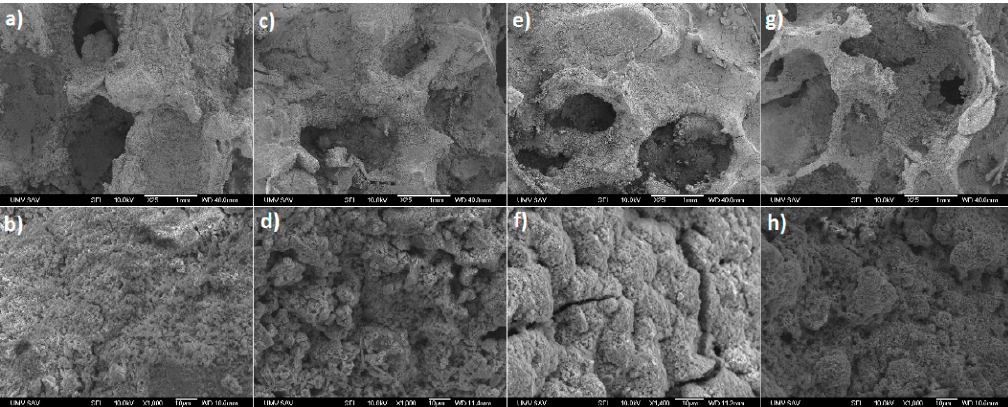
Figure 8. SEM micrographs of sintered iron samples after 12 weeks of corrosion in Hanks’ solution: Fe sample without PEG ( a , b ); Fe-PEG1, 0.8 wt. % PEG ( c , d ); Fe-PEG2, 1.5 wt. % PEG ( e , f ); and Fe-PEG3, 3.0 wt. % PEG ( g , h ). Detail of the surfaces above at a higher magnification ( b , d , f , h ).